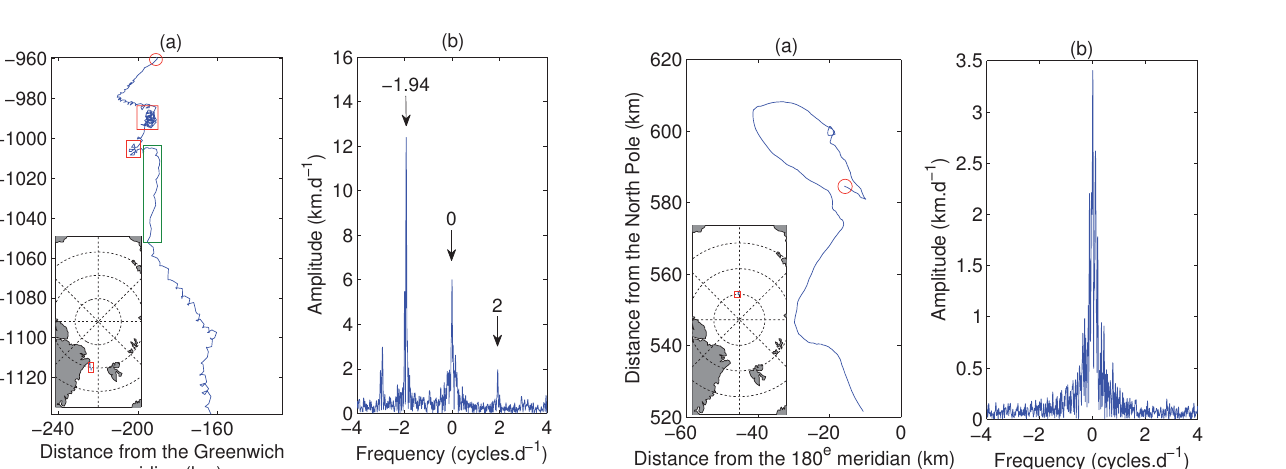
Fig. 4. (a) 1month sample of the trajectory of IABP buoy 1897 (30 August to 30 September 1987). The location of the buoy is indicated by the red box in the inset of Fig. 4a. The red boxes show periods when cycloidal loops are best observed, whereas the amplitude of the loops is much lower in the green boxes. (b) Fourier spectrum of the buoy velocity. The velocity is computed following Eq. (3) with 1t = 3h.